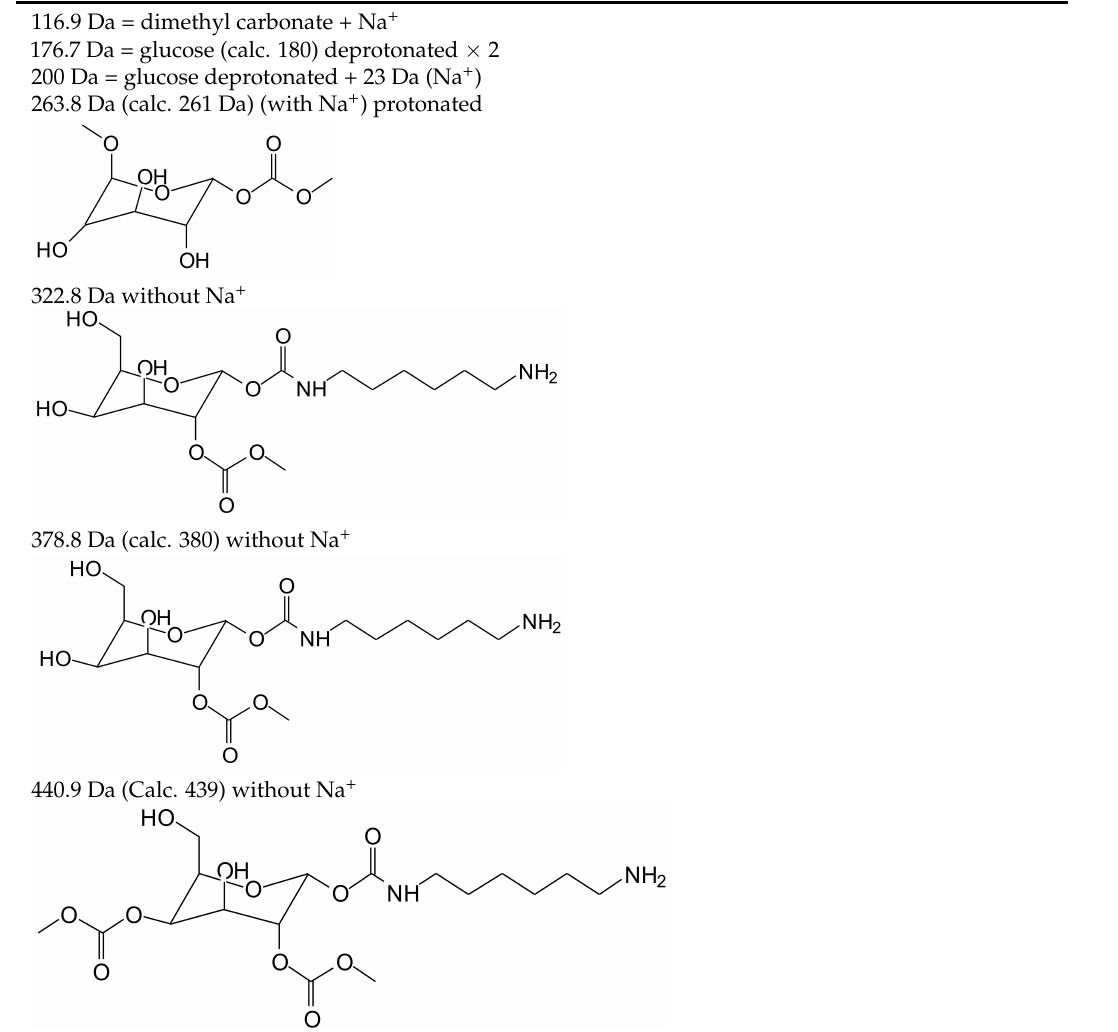
Figure 7. An example of one of the possible branched structures of the trimer at 1225.6 Da. The existence of branched species indicates that these resins do cross-link, as the results found, and are discussed later for both bonding and coating. Table 1. Proposed oligomer structures for the MALDI ToF spectra peaks in Figures 1–4 for the reaction of carbonated glucose with a